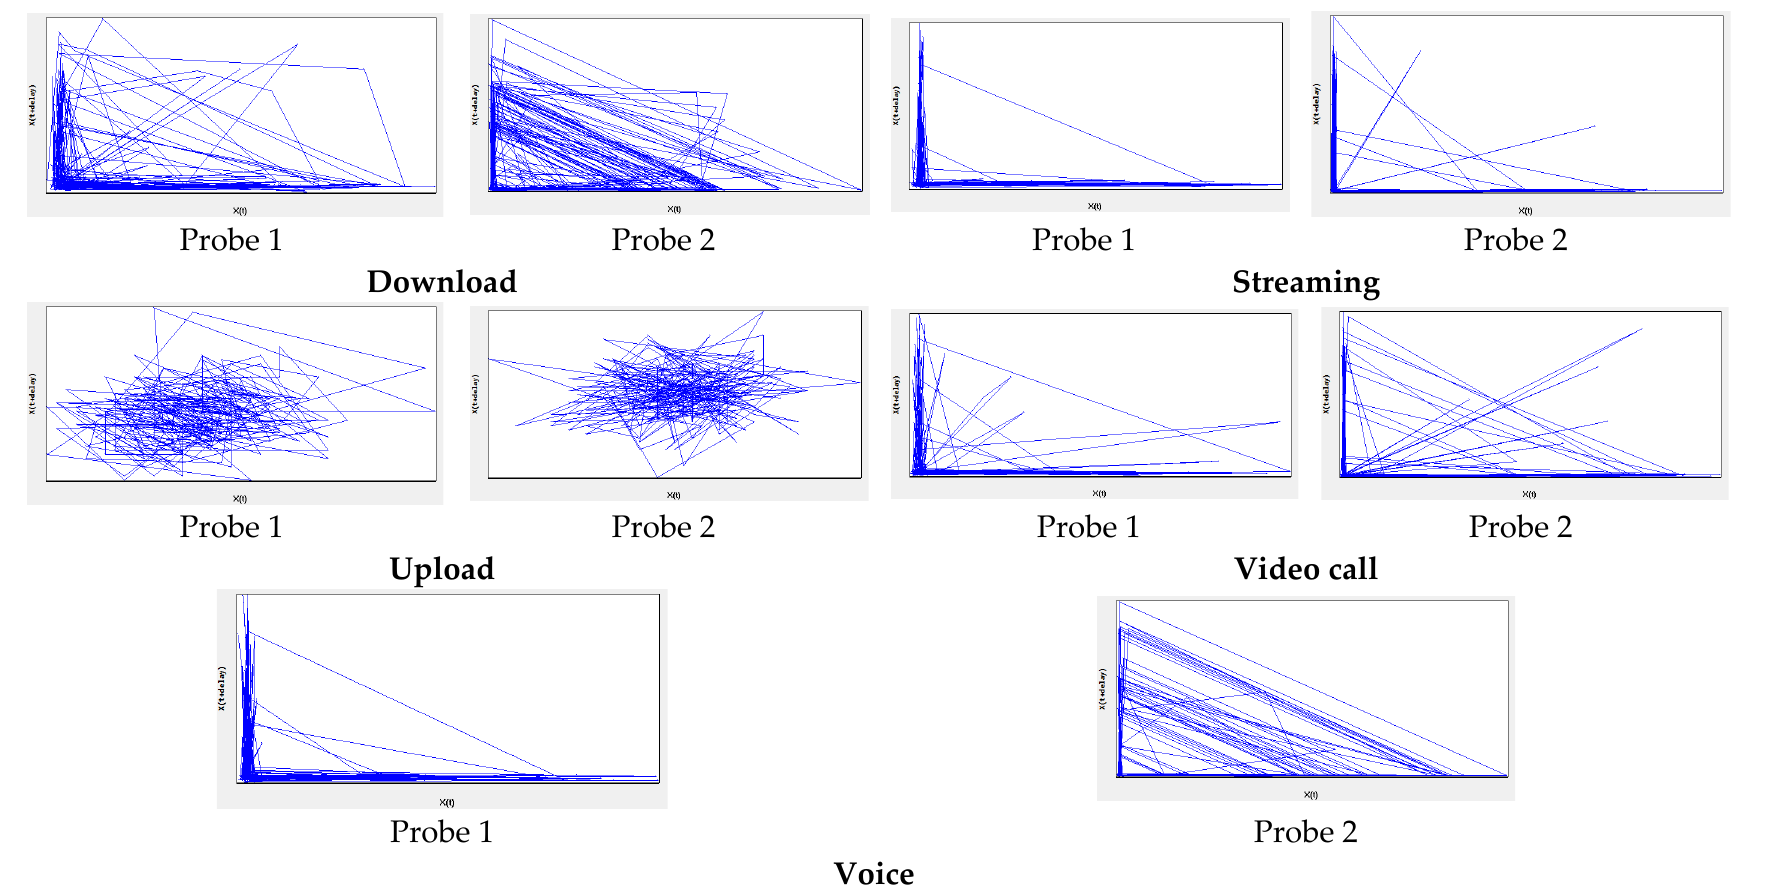
Figure 12. Phase-space plots corresponding to all five mobile applications for probe 1 and probe 2 .